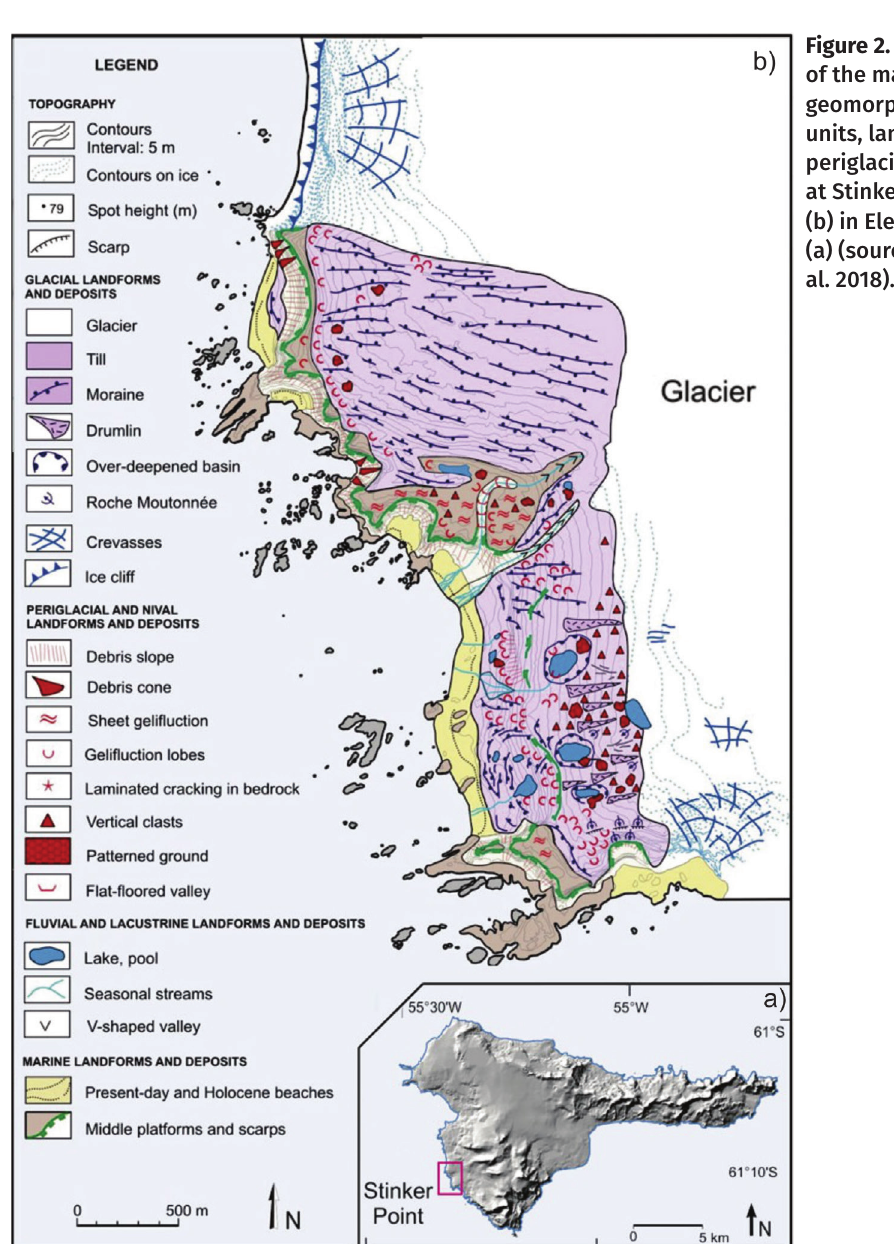
Figure 2. Map of the main geomorphological units, landforms, and periglacial features at Stinker Point